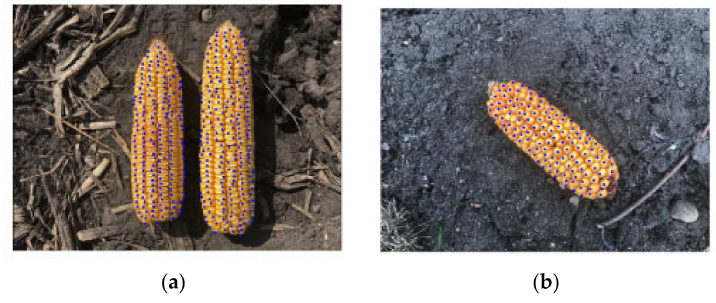
Figure 8. Counting of corn kernels processed in images with CNN